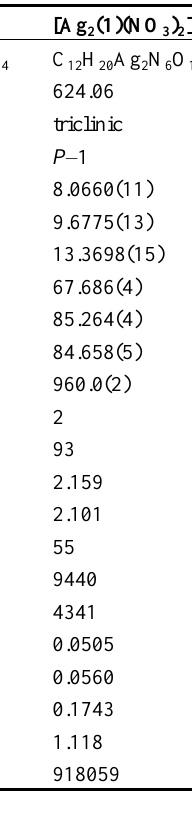
Table 1. Crystallographic data and refinement details for [Ag( 1 )NO